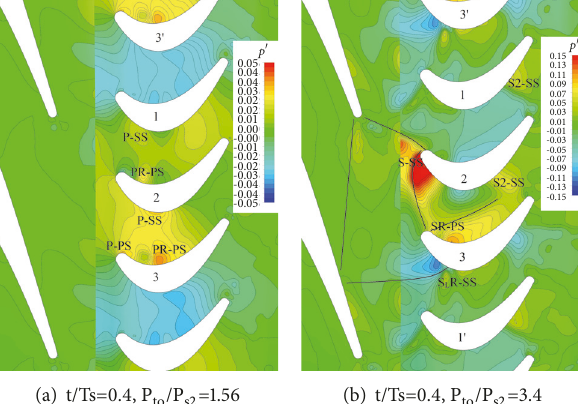
Figure 7: Instantaneous pressure fluctuation contour at rotor midspan at low and nominal pressure ratio operating conditions.